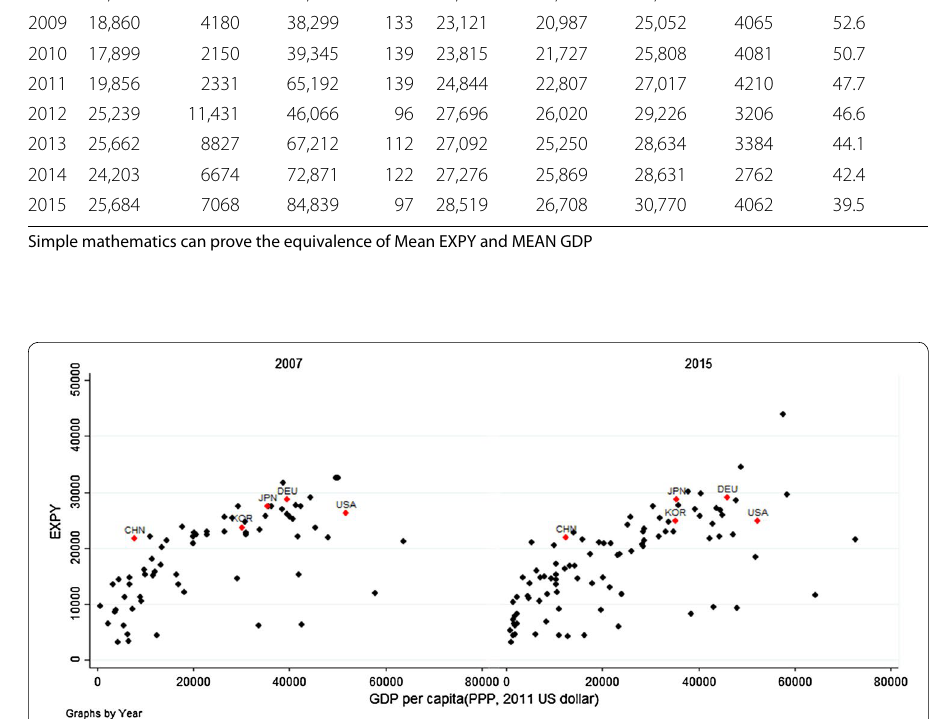
Fig. 6 Position of countries in GDP-EXPY distribution. Each dot represents productivity level and GDP of country. Some interested countries are depicted as red color. Source : Penn World Table, Author’s calculation